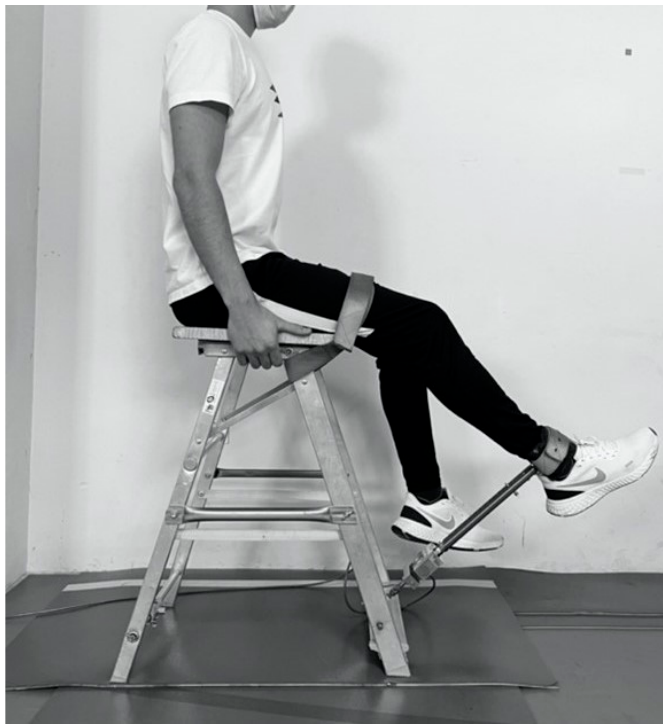
Figure 1. Image of the custom-built bench, placement of the portable strain gauge and participant’s position for the measurement of hamstring and quadriceps strength using a field-based test.